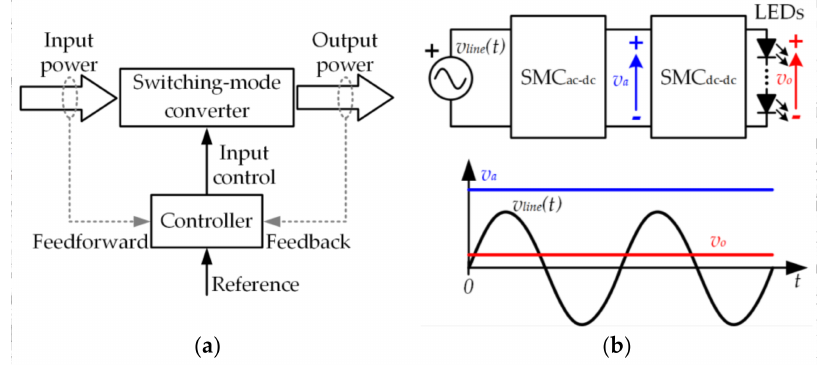
Figure 3. ( a ) Basic power processing block of a switching-mode converter; ( b ) Two-stage power conversion architecture of solid-state lighting